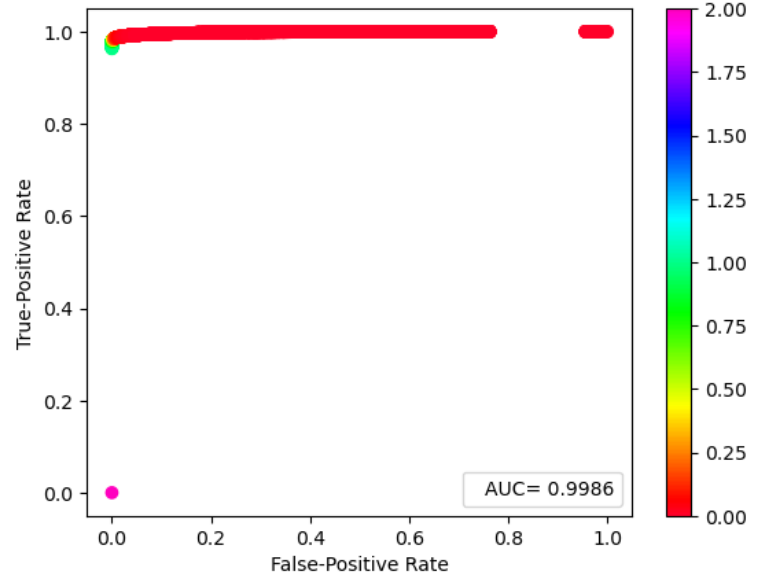
Figure 10. True positive rate as a function of false positive rate (ROC curve) scaled considering the threshold used to decide if there are transits or not. The probabilities should be lower than 1.0. The pink dot (with a value of 2.0) does not represent predictions because it is an arbitrary value used as a starting point for the process. We also plot the value of the computed